Question: Write a single sentence explaining what this figure depicts.
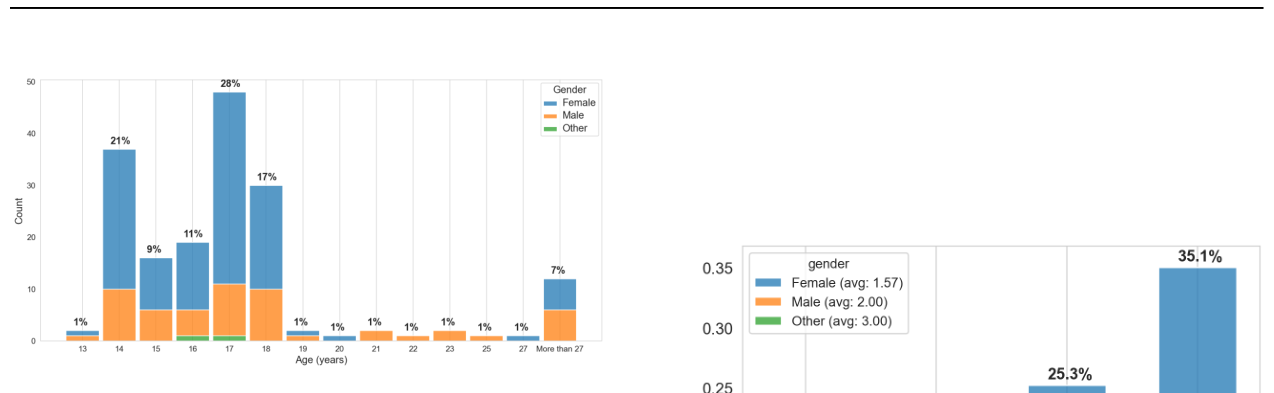
Answer: Age distribution of participants.